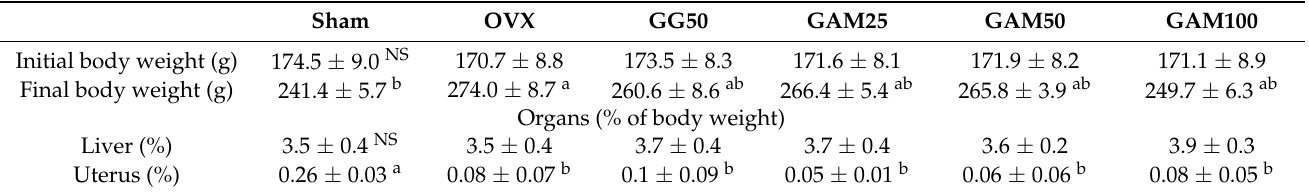
Table 1. Effects of GAM mixtures on body and organ weights of the OVX-induced rat model.